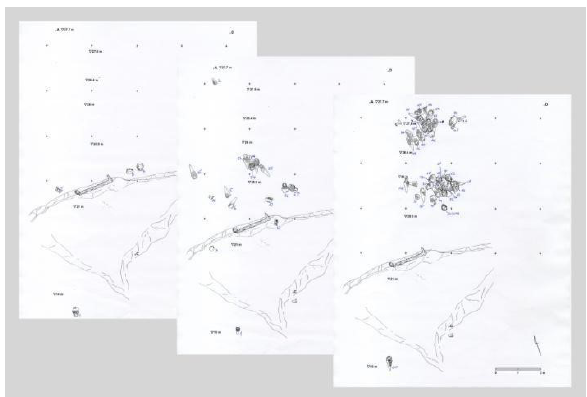
Figure 4. Processing of the measurements of DSM with Site Recorder